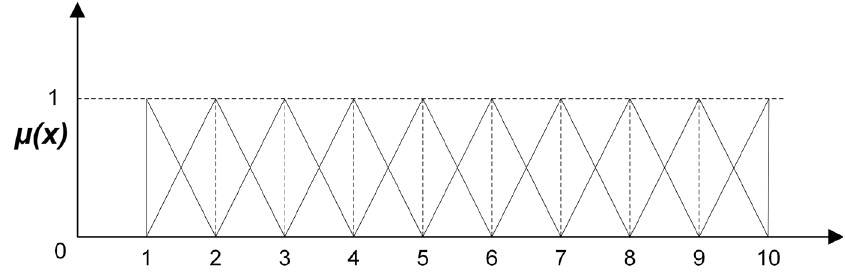
Figure 2. Fuzzy environment